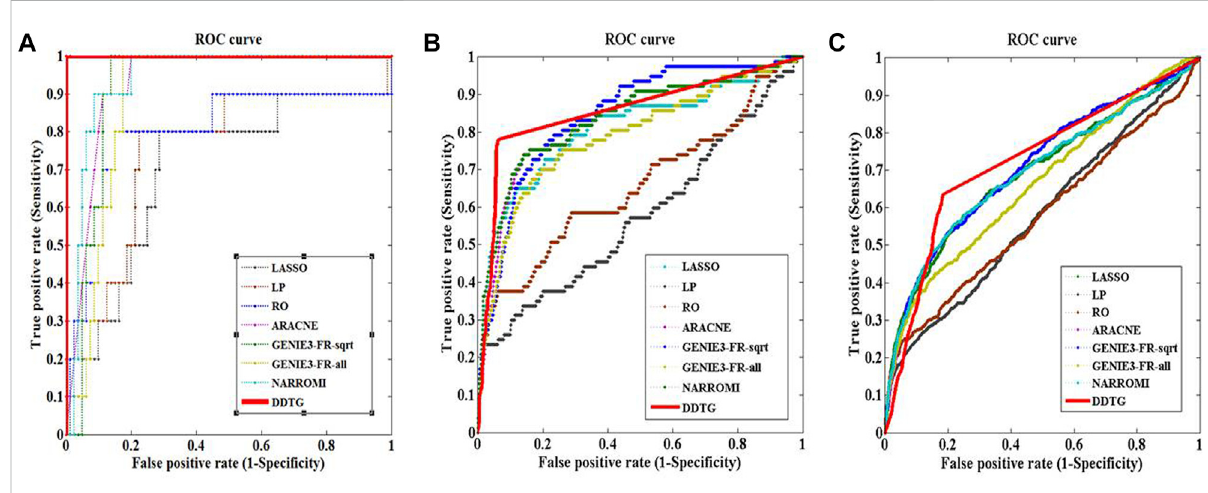
FIGURE 3 ROC curves ofseveralmethods onnetworkswith differentsizes. The solidline with star points istheROC curveofmethodDDTG. (A) The ROC curves on the network with size 10. (B) The ROC curves on the network with size 50. (C) The ROC curves on the network with size